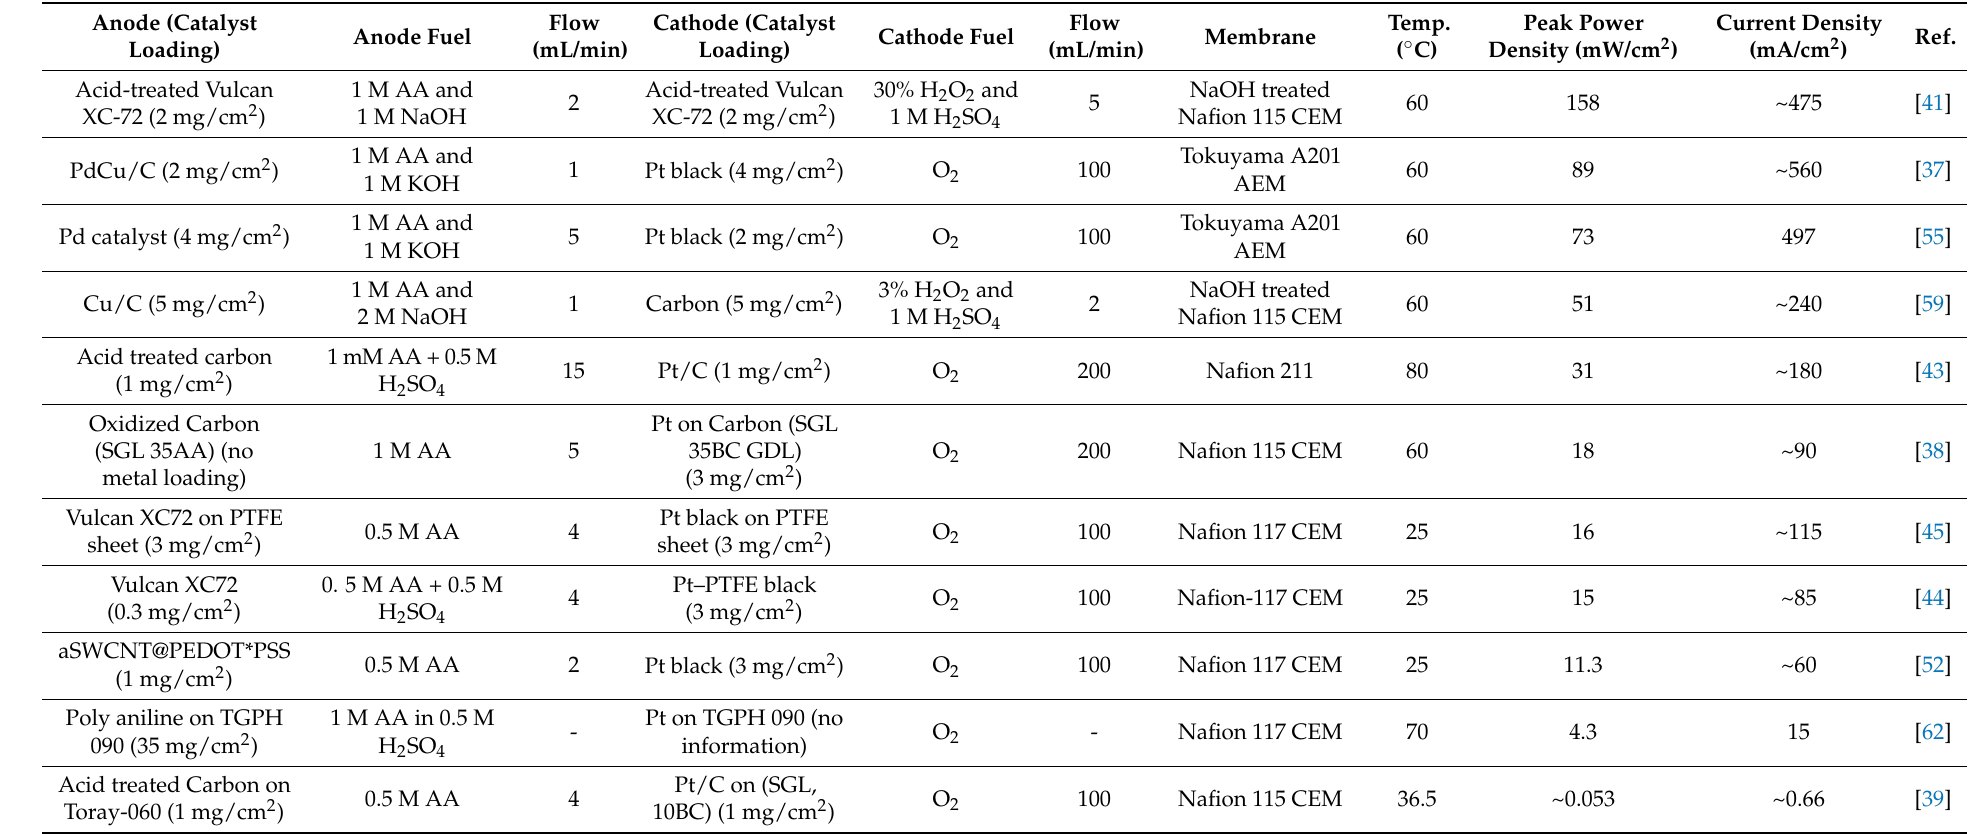
Table 1. Summarized data of AA-based fuel